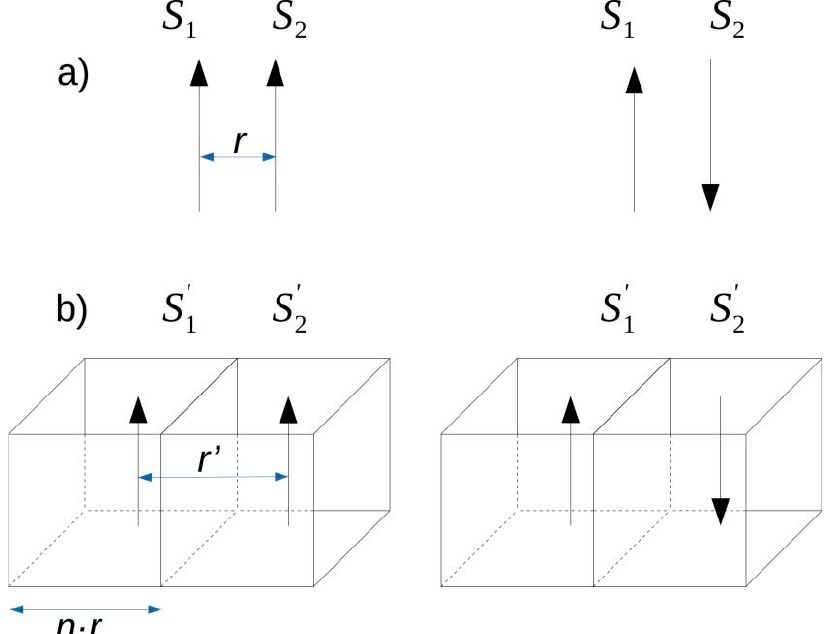
Figure 1. The idea of the spin system re-scaling defined by the enlargement factor n . ( a ) spin configuration for the original system; ( b ) spin configuration for the re-scaled system.